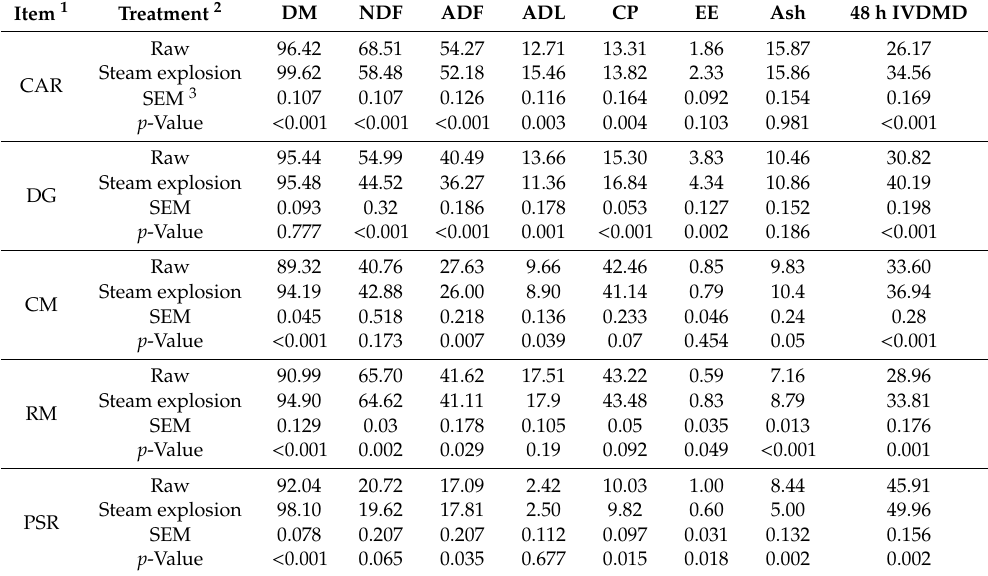
Table 1. E ff ect of steam explosion treatment on the chemical composition and in vitro digestibility of five byproduct feedstu ff s (DM basis, expressed as %).